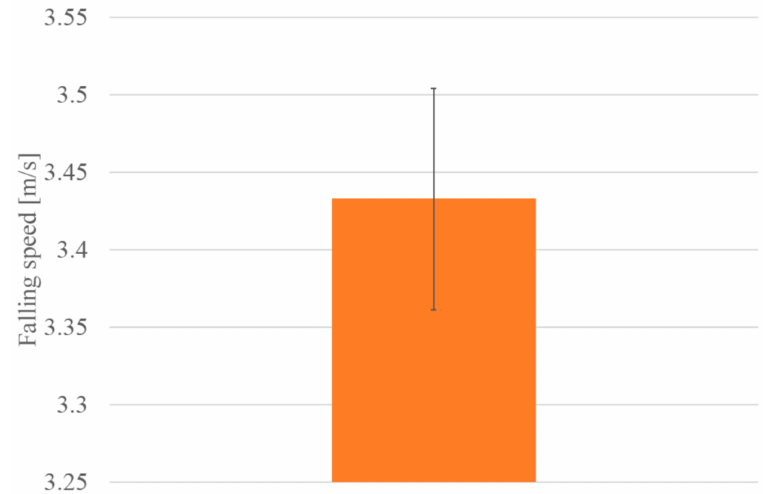
Figure 22. Experimental results of falling